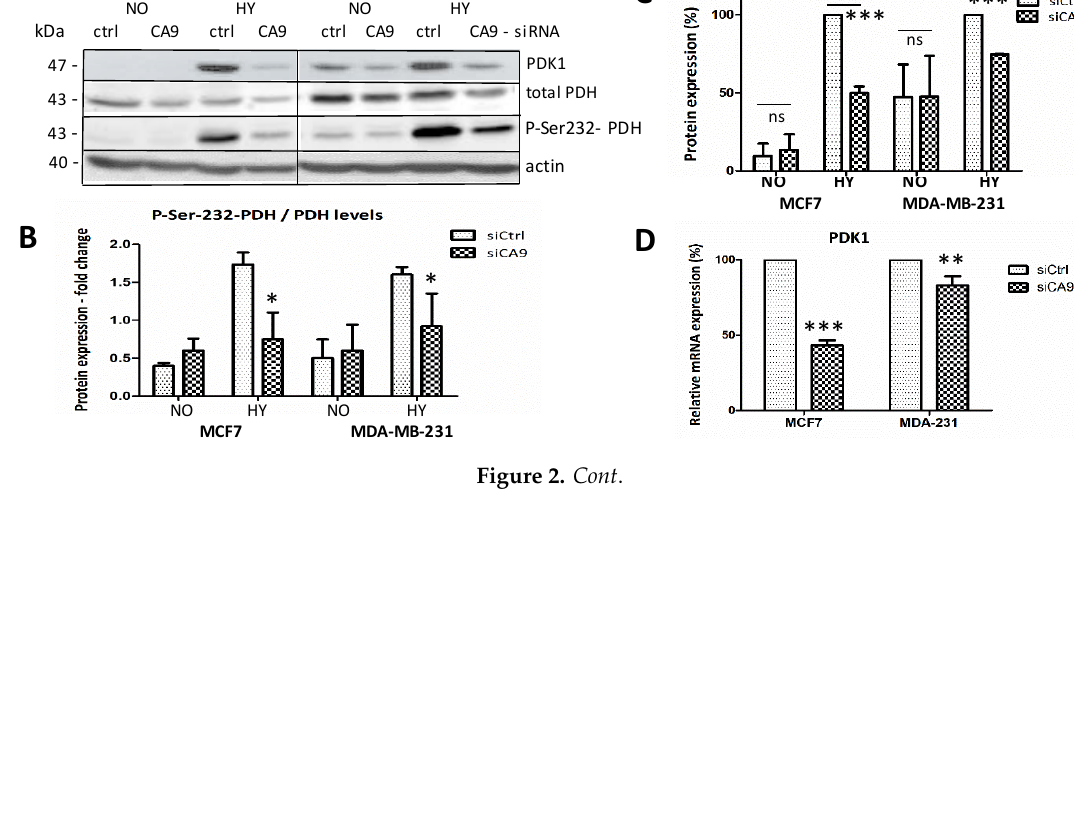
Figure 2. The effect of CAIX suppression on the glycolytic pathway. ( A ) Representative Western blot of PDK1 (Pyruvate dehydrogenase kinase 1), total PDH (Pyruvate dehydrogenase), and pSer232-PDH in silenced MCF7 and MDA-MB-231 cells, incubated in normoxia (NO) or hypoxia (HY), with graphic illustration ( B ) of the proportion of Ser-232- phosphorylated-PDH to total-PDH (signal quantified via ImageJ software). ( C ) PDK1 signal from three different immunoblots quantified via ImageJ software and normalized to internal control. Hypoxic control was set as 100%. ( D ) Quantitative PCR of PDK1 mRNA in hypoxic control and CA9-silenced cells normalized to actin, presented as a percentage of control expression. The results represent the mean from three independent biological experiments done in triplicates. ( E ) Representative Western blots and their signal quantification of hypoxic control